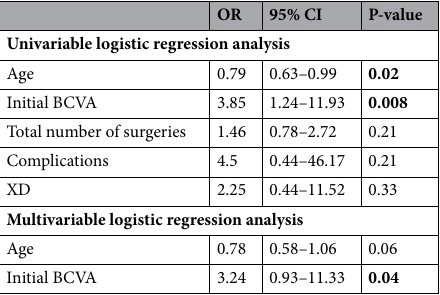
Table 3. Variables associated with functional visual acuity. OR, odds ratio; CI, confident interval; P, probability; BCVA, best-corrected visual acuity; XD, external drainage of subretinal fluid. Significant P values are shown in bold.